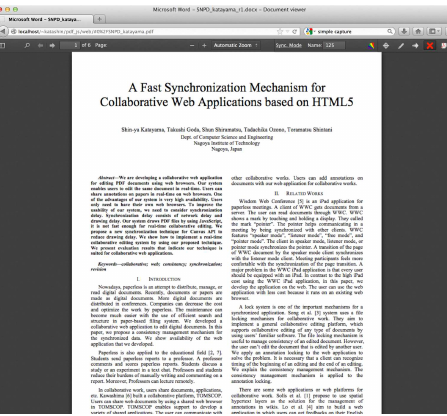
Fig. 3. User interface of the system.